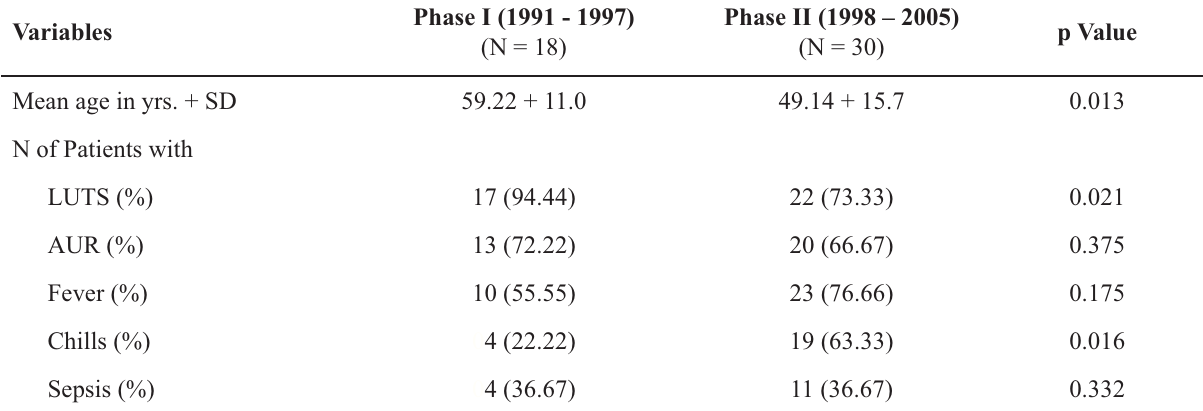
Table 1 – Clinical presentation.